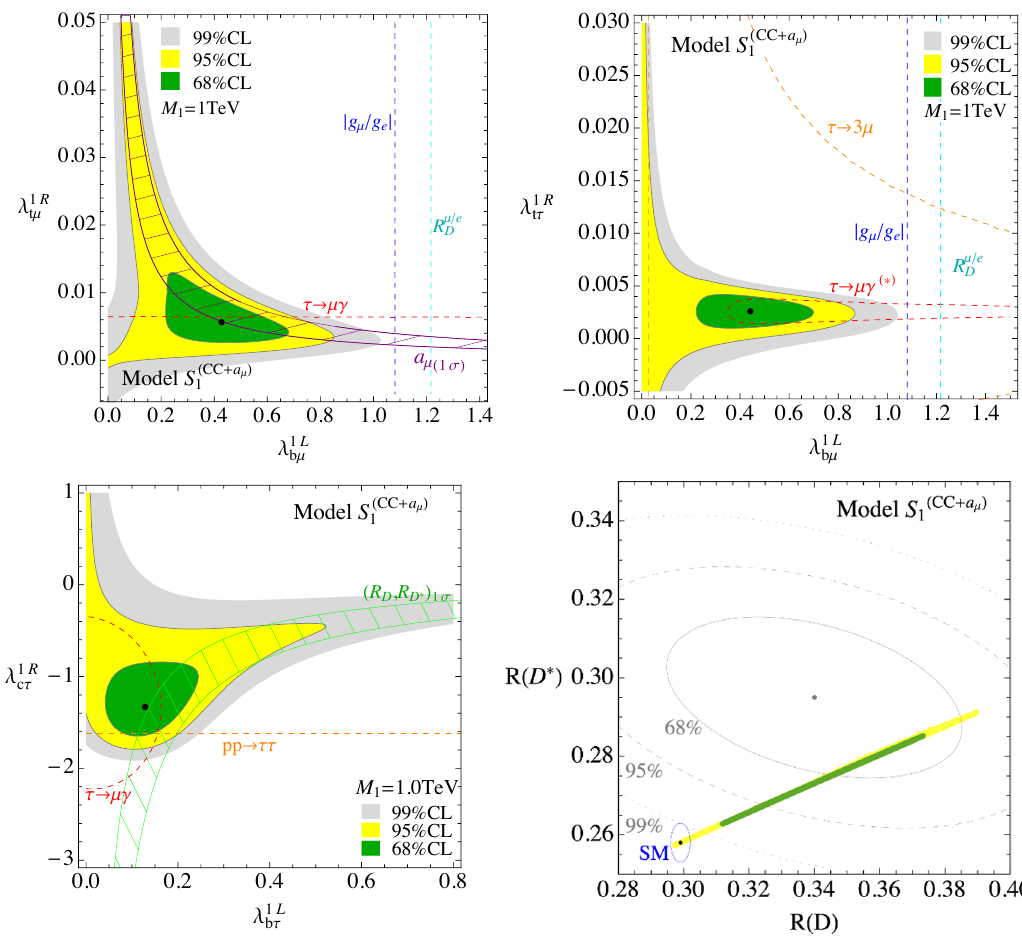
Figure 3 . Result from the fit in the S 1 model aimed to addressing the CC and ( g − 2) µ anomalies. We show the preferred regions in the planes of two couplings, where those not shown are profiled over. The dashed lines show, for illustrative purposes, 2 σ limits from individual observables where the other couplings are fixed at the best-fit point (black dot). In the lower-right panel we show where the preferred region is mapped in the plane of R ( D ) − R ( D ∗ )